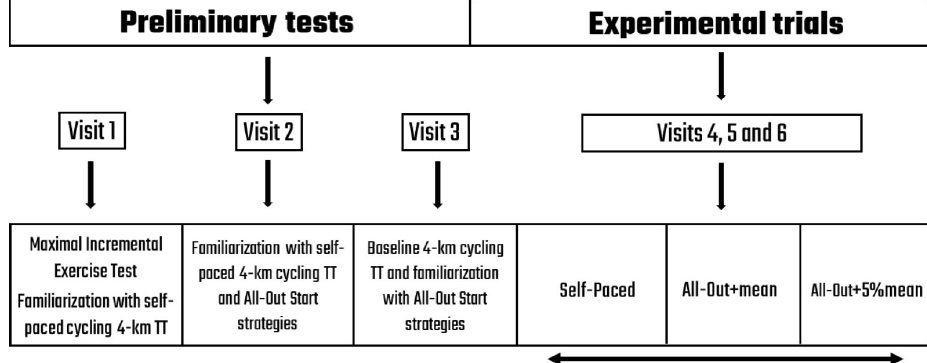
Figure 1. Experimental design. Bidirectional arrow indicates counterbalanced and randomized order. TT: time